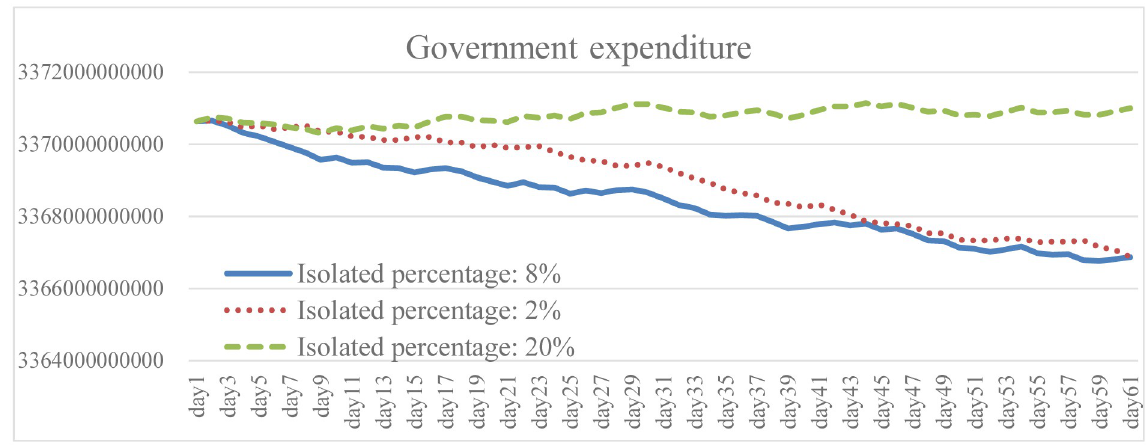
Fig 9. Government expenditure under different isolation